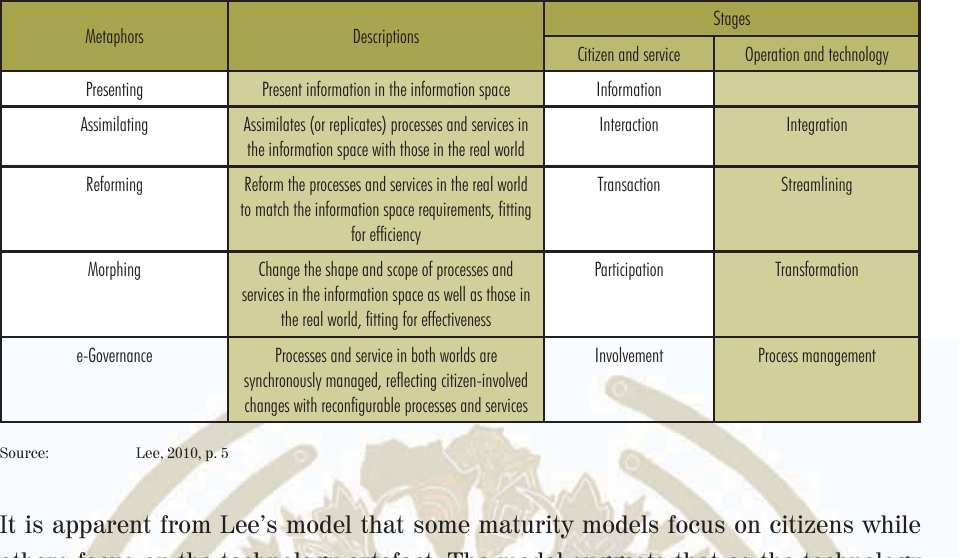
E-GOVERNMENT MATURITY